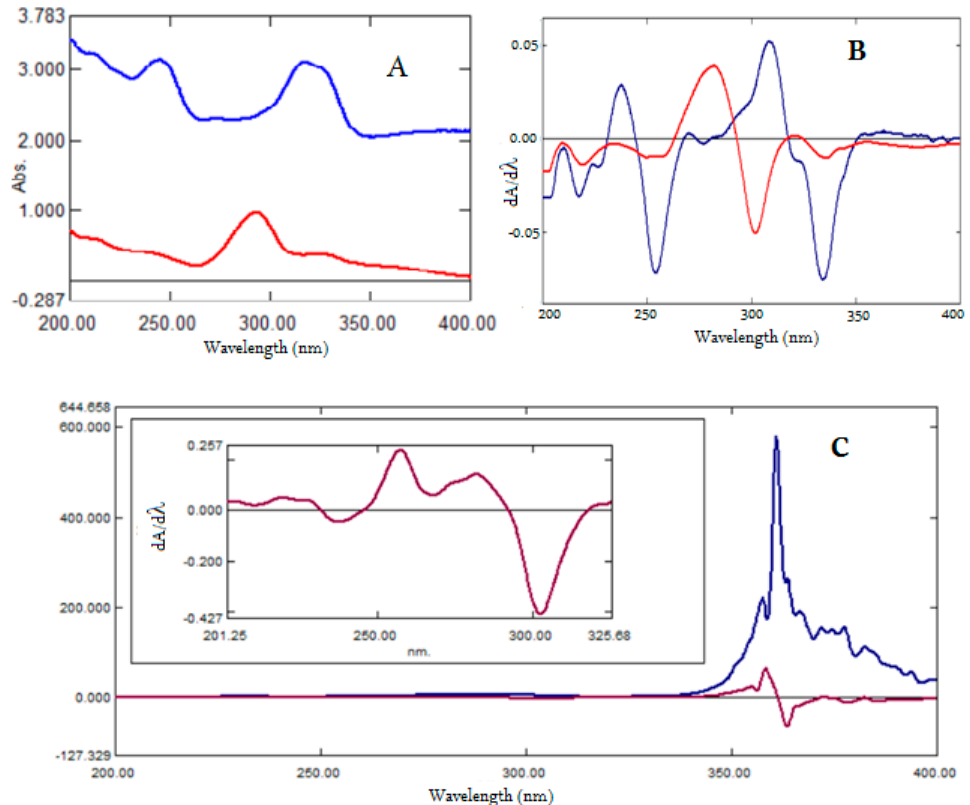
Figure 8. UV absorption spectra of formulation ( A , Red), first derivative UV spectra of formulation ( B , Red). Ratio spectra ( A , Blue) and first derivative of ratio spectra ( B , Blue) of formulation for FLX using four µ g/mL solution spectra of MOX as devisor. Ratio spectra ( C , Blue) and first derivative of ratio spectra ( C , Brown) of formulation for MOX using four µ g/mL solution spectra of FLX as devisor, with enlarged part of ratio first derivative spectrum from 201 nm to 325 nm.